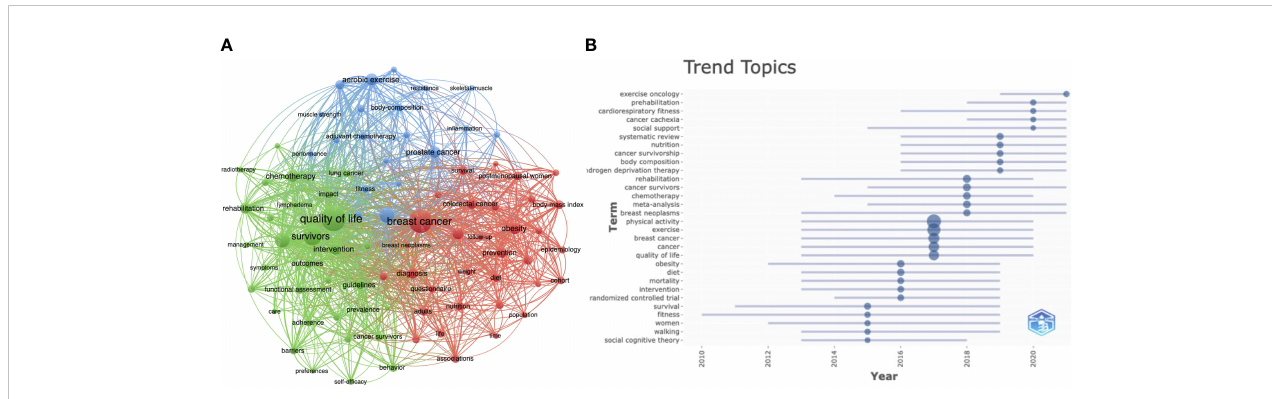
FIGURE 6 Analysis of Hotspots and Trends in Research. (A) Keyword co-occurrence visualization map. (B) Timeline of research trends in the fi eld of PA, SB, and cancer.